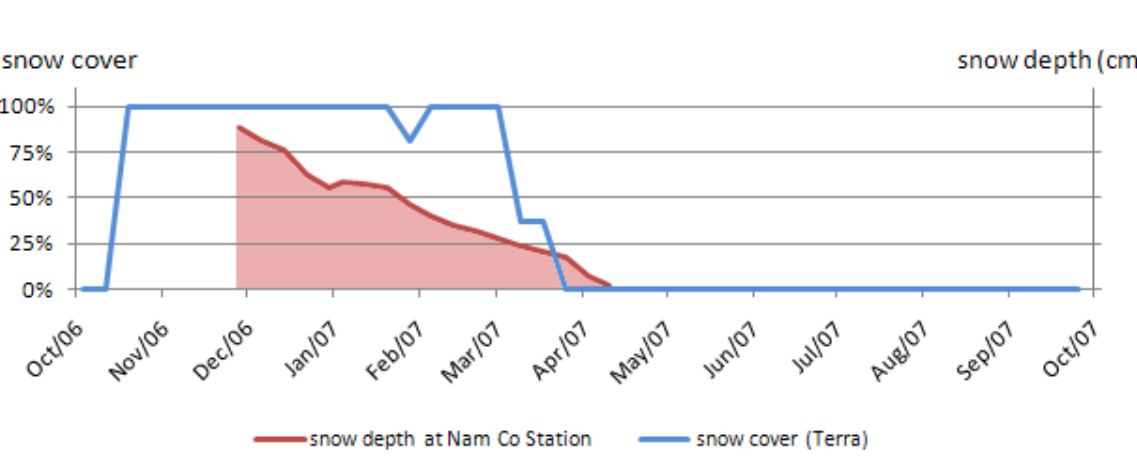
Figure 6. Comparison of snow cover percentage at the Nam Co Station from MODIS Terra (16 pixels around the station) with ground snow depth measurements for year 2007. The snow depth measurements started in November 2006 and they are only sparse in the following years. Averaged measurements over three plots inside and in the vicinity of Nam Co Station are